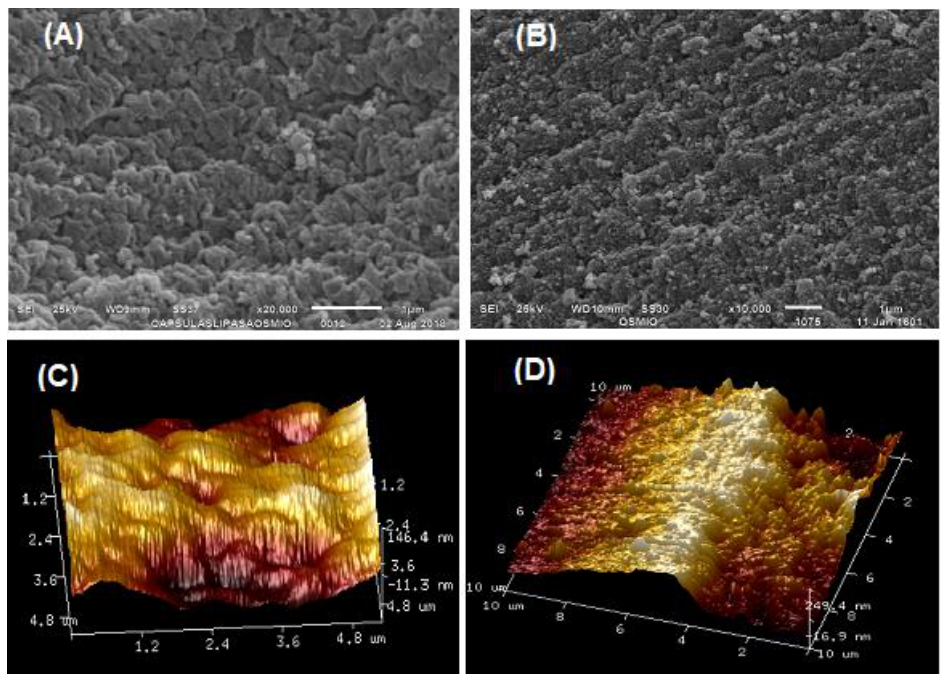
Figure 2. SEM images and three-dimensional AFM surface topology of samples. (A) and (C) are samples were with CALb lipase; (B) and (D) are samples were with vegetal lipase.